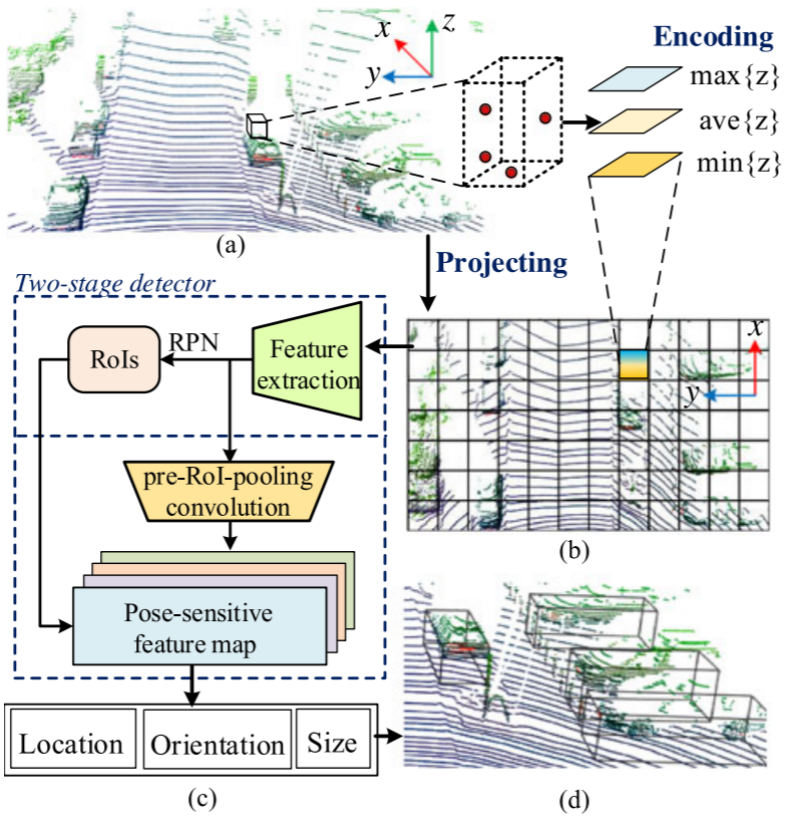
Figure 11. The pipeline of RT3D [61]: ( a ) LiDAR-based 3D point cloud on ( b ) a depth map encoded with height information of points; ( c ) a CNN-based two-stage detector is utilized for region proposals generation and their classification on pose-sensitive feature maps; ( d ) visualization of detected vehicles with orientated 3D